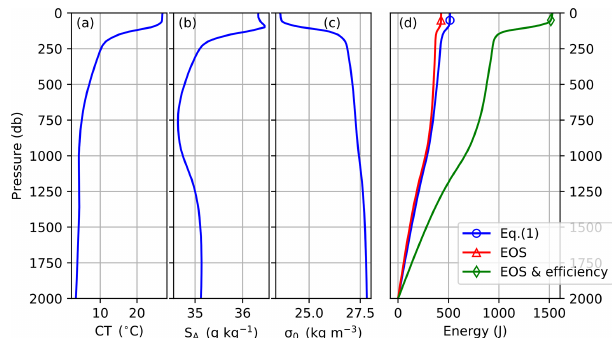
Figure 2. Profiles of (a) conservative temperature, (b) absolute salinity, (c) potential density anomaly and (d) energy consumed. The energy shown is that required to ascend from 2000db toward surface estimated by the two last terms of Eq. (1) (blue), calculated from the full EOS of both water and hull (red) and also accounting for the pump efficiency from Fig. 1 (green). The example profile is from the tropical Atlantic (WOA18; 5.5 ◦ S, 25.5 ◦